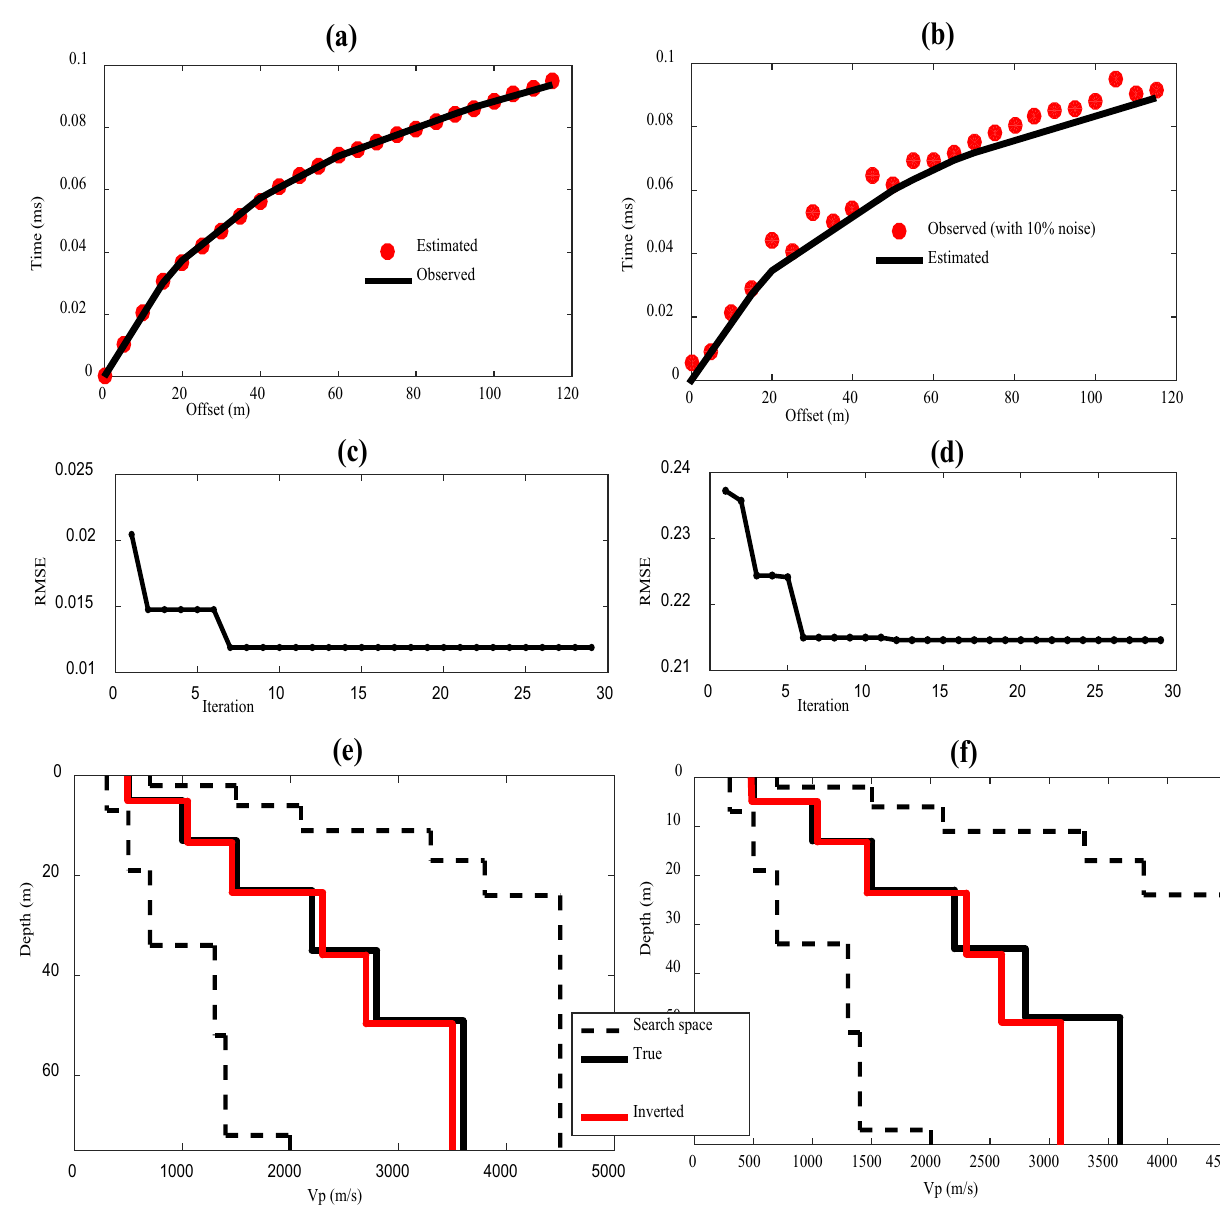
inversion of the model, respectively, without noise and in the pres- ence of 10% noise, e the modeled Vp profile (the red line) by the inversion of model B (without noise), f the modeled Vp profile (the red line) by the inversion of model B in the presence of 10%